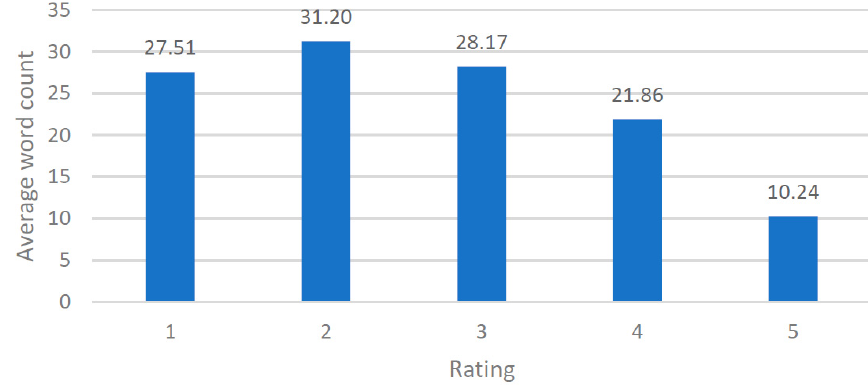
Figure 7. Average word count by ratings.